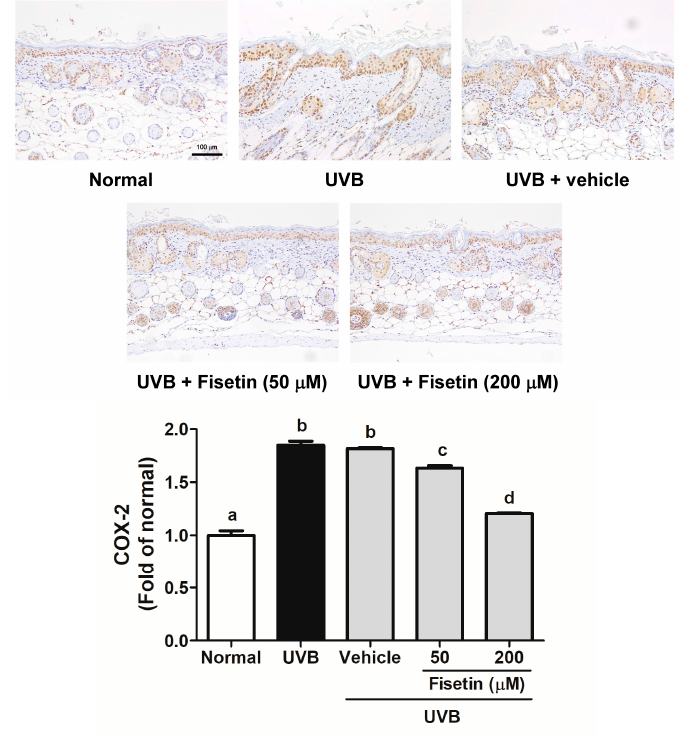
Figure 9. Immunohistochemical staining of COX-2 expression in the epidermis of the mouse skin slices. Fisetin inhibits UVB-induced COX-2 overexpression (200×). a–d: Values not followed by a common letter are significantly different ( p < 0.05).